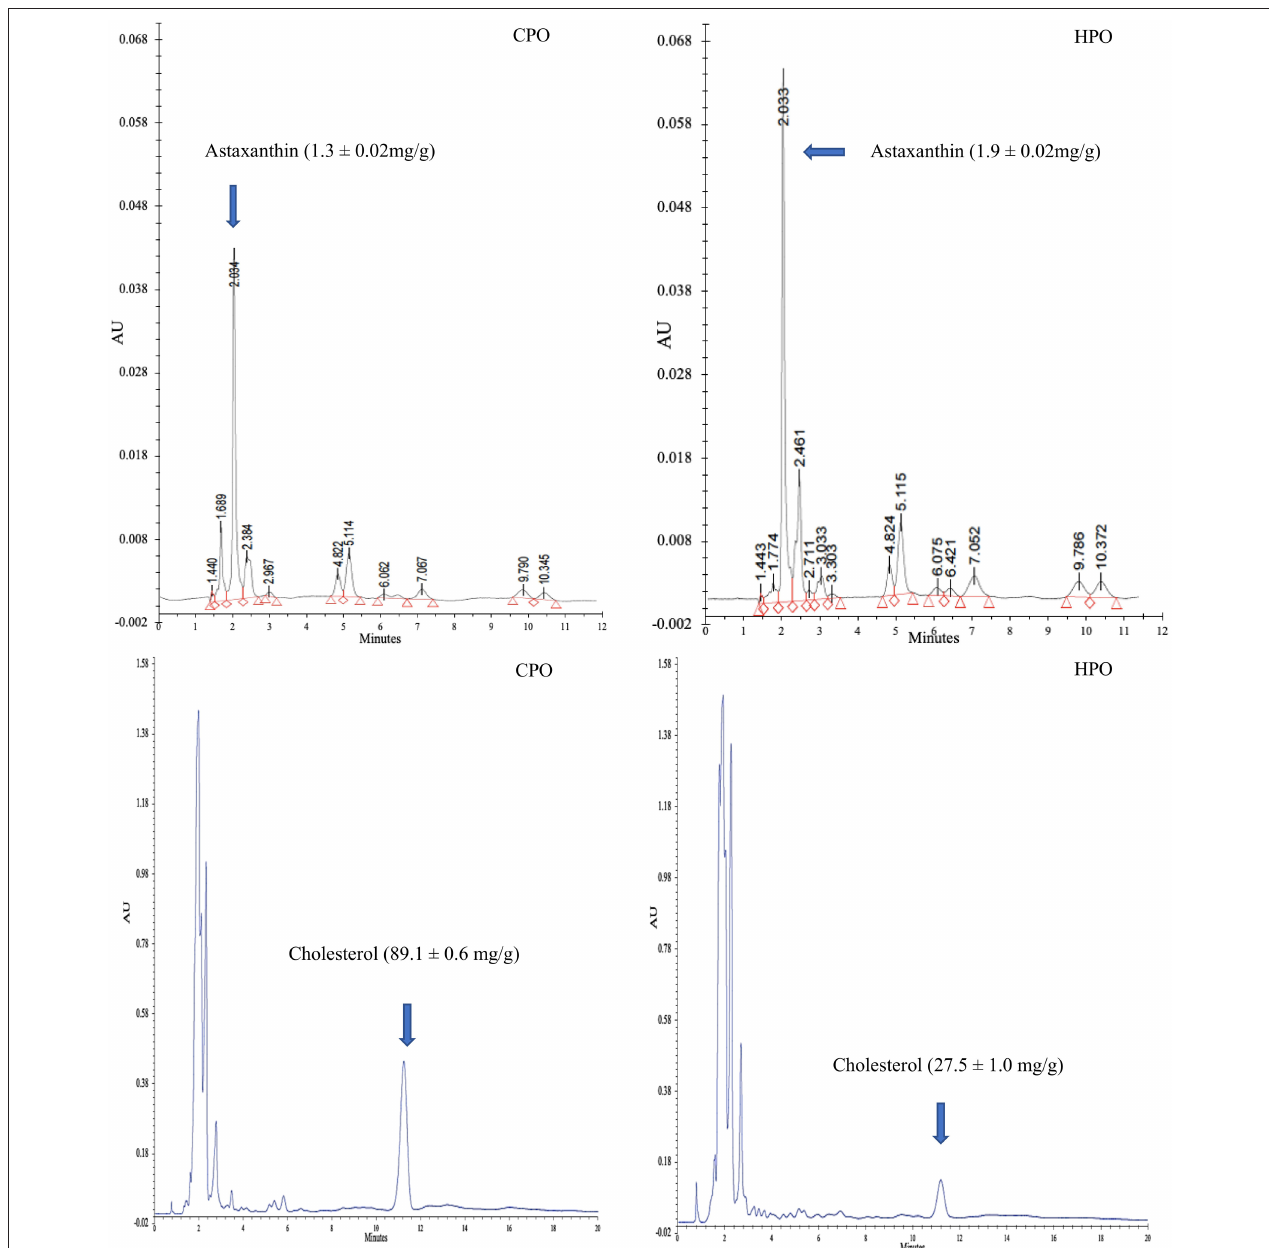
FIGURE 1 | HPLC chromatogram of astaxanthin and cholesterol from CPO and HPO. CPO: Oil extracted from cephalothorax; HPO: oil extracted from